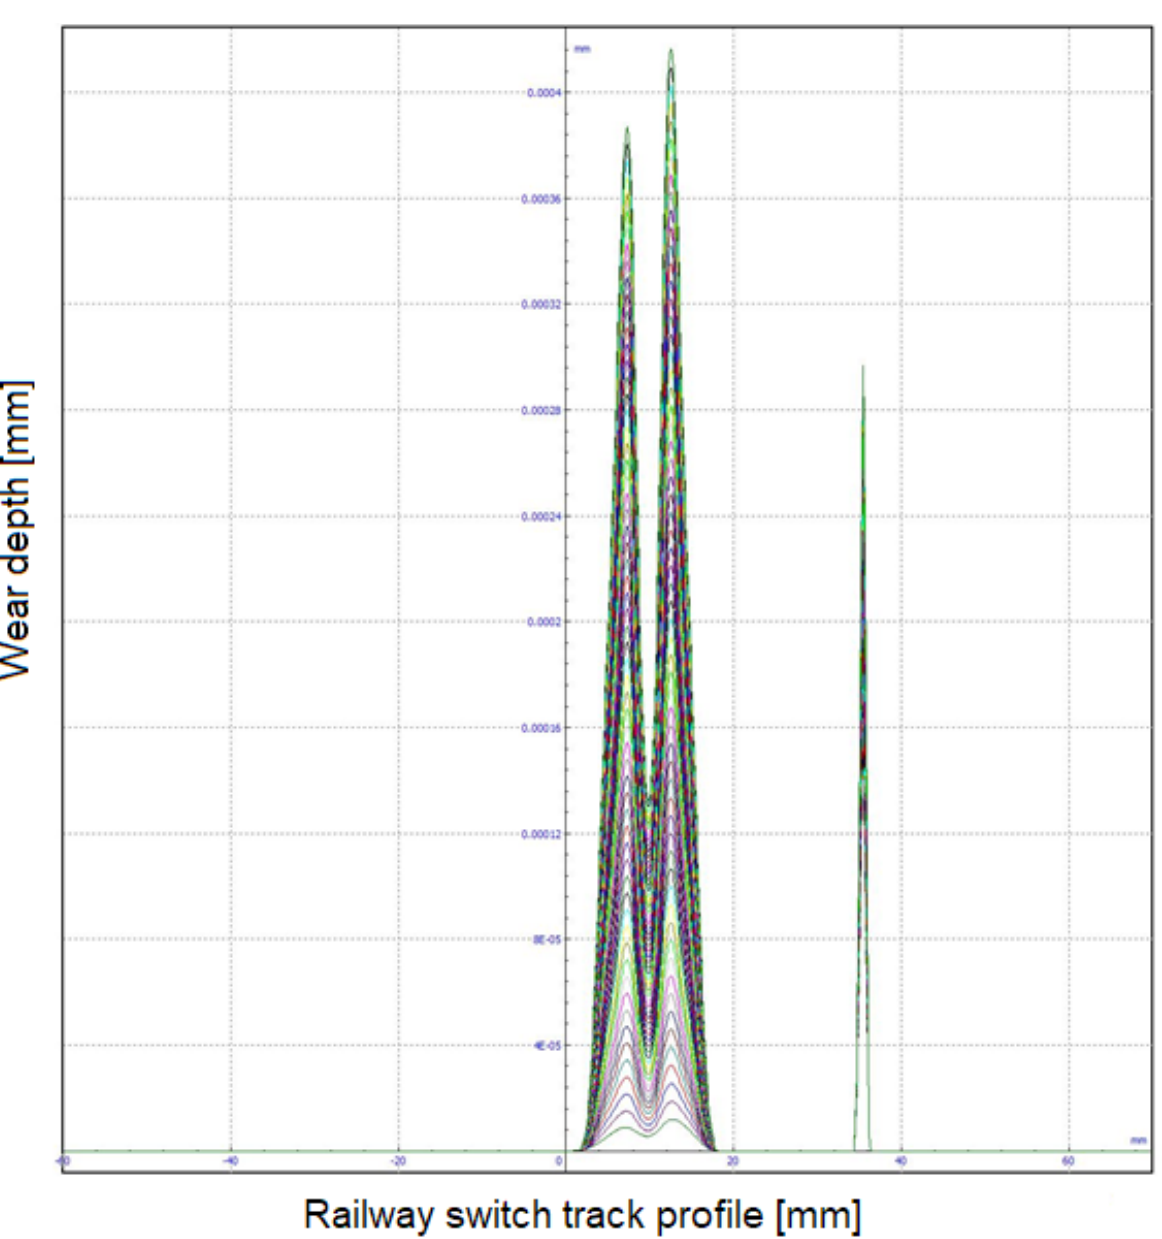
Figure 41. Rail wear for a straight track without a turnout with constant stiffness obtained at 200 km/h. The maximum value of wear is above 0.0004 mm.